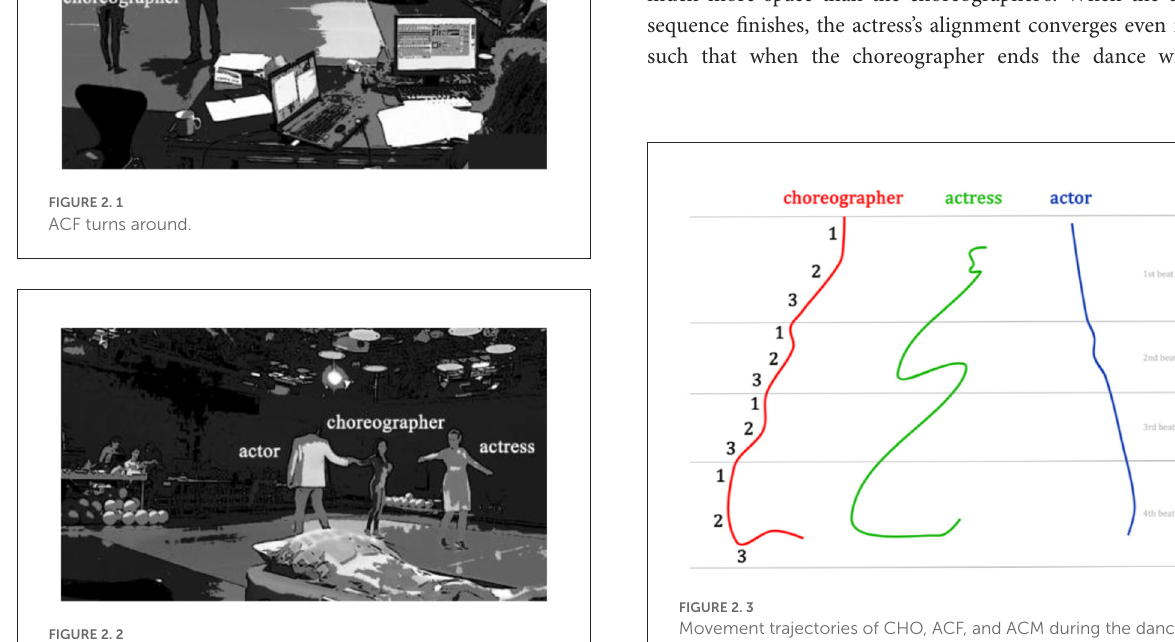
FIGURE2.2 CHO, ACF, and ACM dance together.